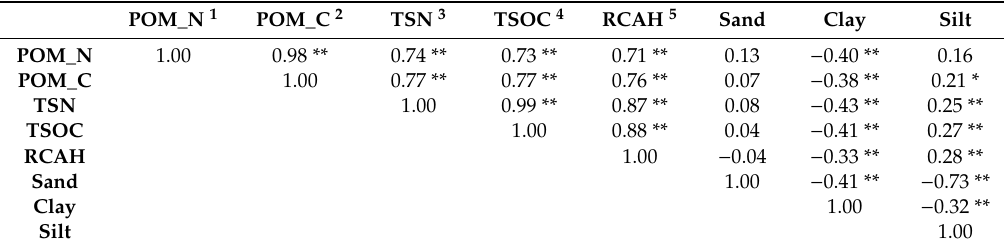
Table 3. Correlations between edaphic properties and soil nitrogen (N) and carbon (C) fractions. POM_N 1 POM_C 2 TSN 3